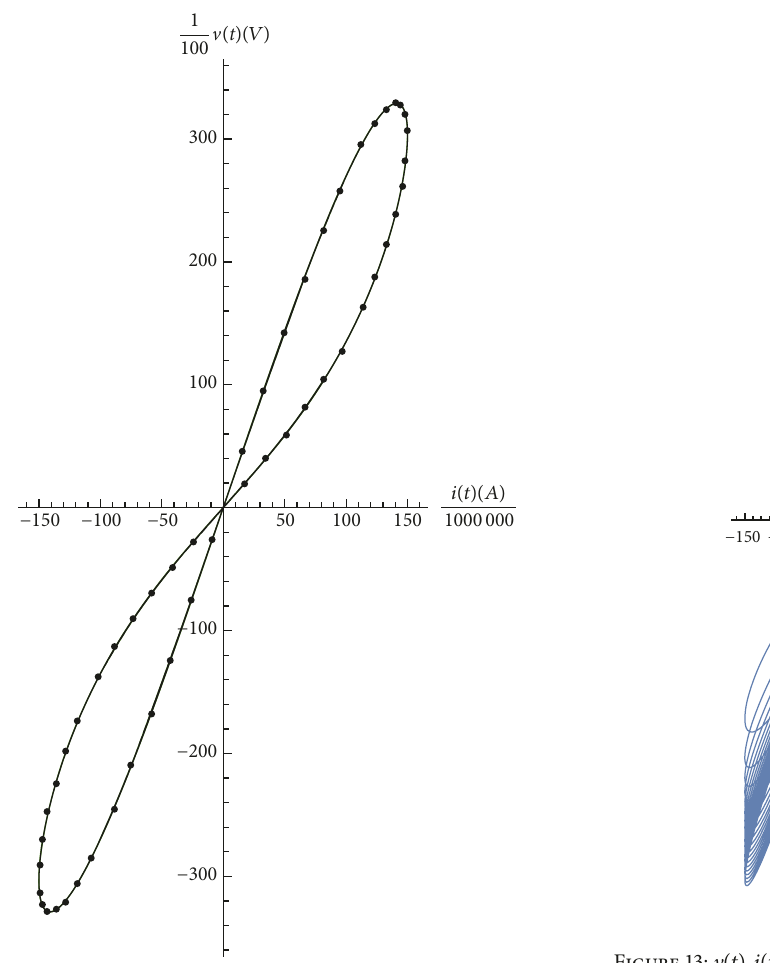
Figure 12: V (𝑡) - 𝑖(𝑡) of the fractional order memristor (green) and HP memristor (black dots): 𝛼 = 1 and 𝐼 𝑚 < 0.